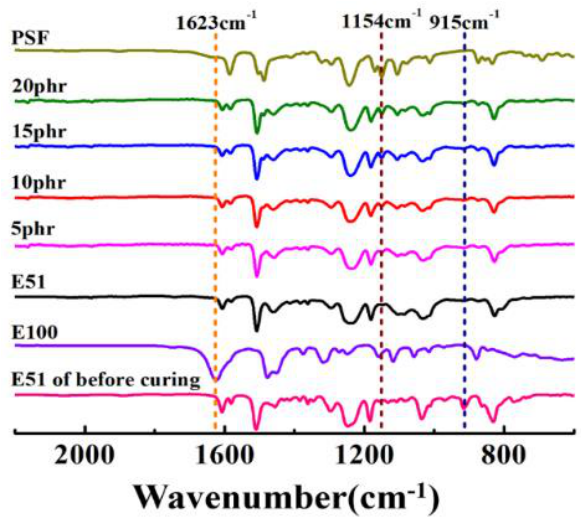
Figure 4. Fourier transform infrared (FT-IR) spectrum of epoxy resin (E51) before curing, the PSF/epoxy blends after curing with different PSF content and PSF.